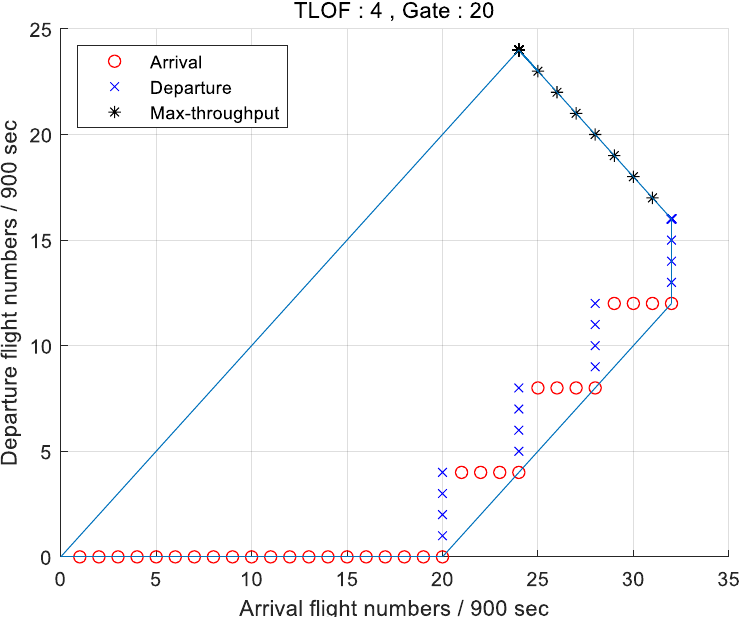
Figure 38. Capacity of a pier topology for the expanded Gimpo Airport parking lot that complies with the EASA’s new regulations. Table 9. Results of each topology for the expanded Gimpo parking lot space that complies with the FAA’s new regulations.